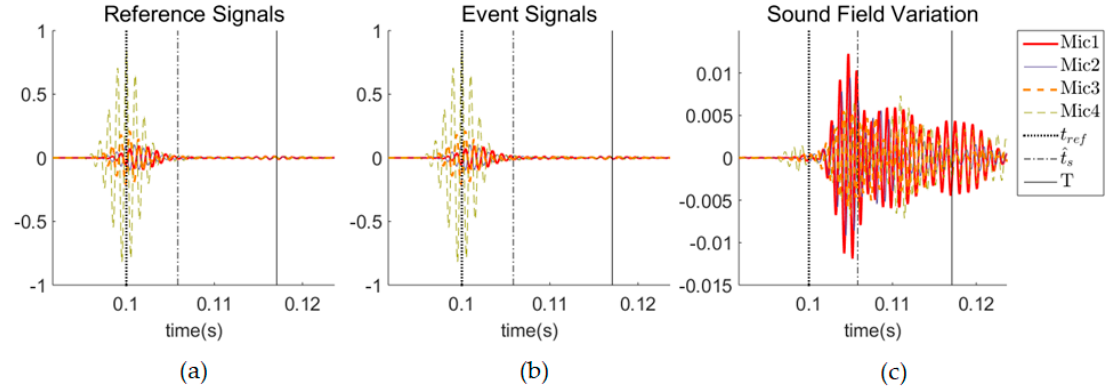
Figure 4. Example of measured signals: ( a ) Reference signals before intrusion; ( b ) event signals after intrusion; ( c ) sound field variation.